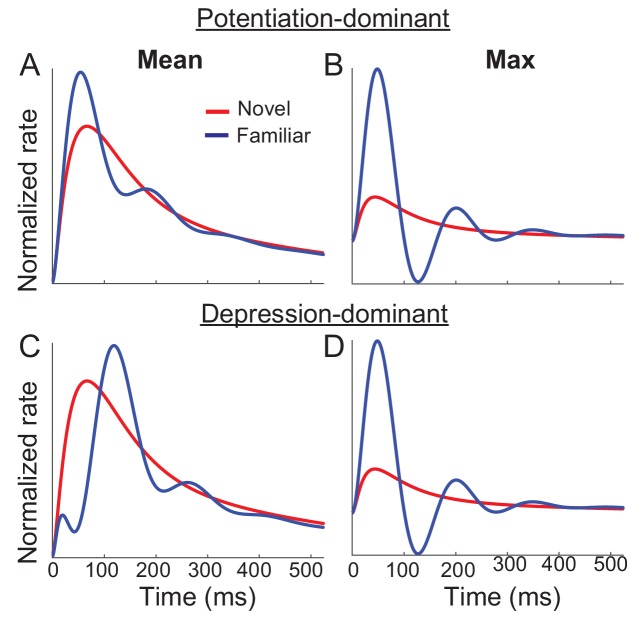
Networks with synaptic plasticity only in recurrent connections with slow negative feedback.Average (A,C) and maximal (B,D) response before (red) and after (red) learning with potentiation-dominant (A,B) or depression-dominant (C,D) synaptic plasticity rules. The simulation of the mean-field dynamics is the same as in Figure 5 with the same parameters except f¯F=0, f¯R=0.1 (A,B), and f¯R=−0.2 (C,D).